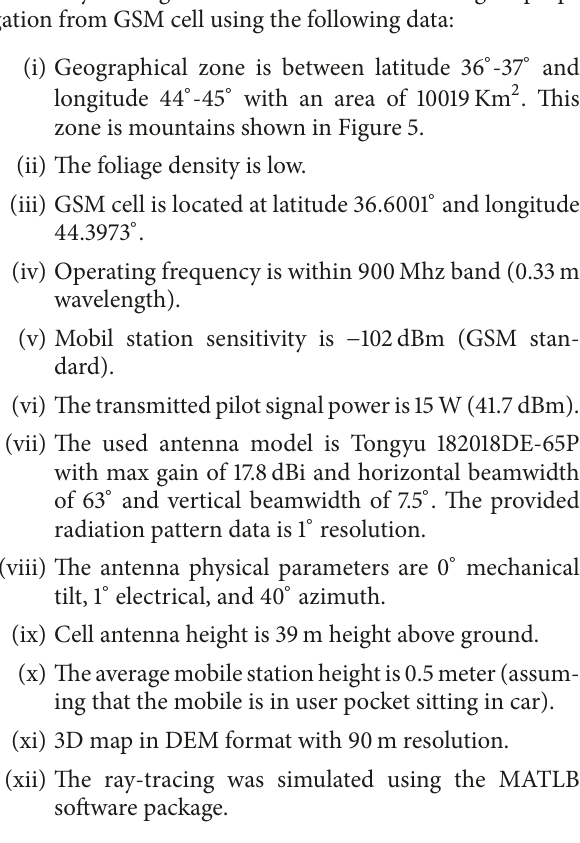
Figure 6: Measurement route (pink path) overlaid on prediction